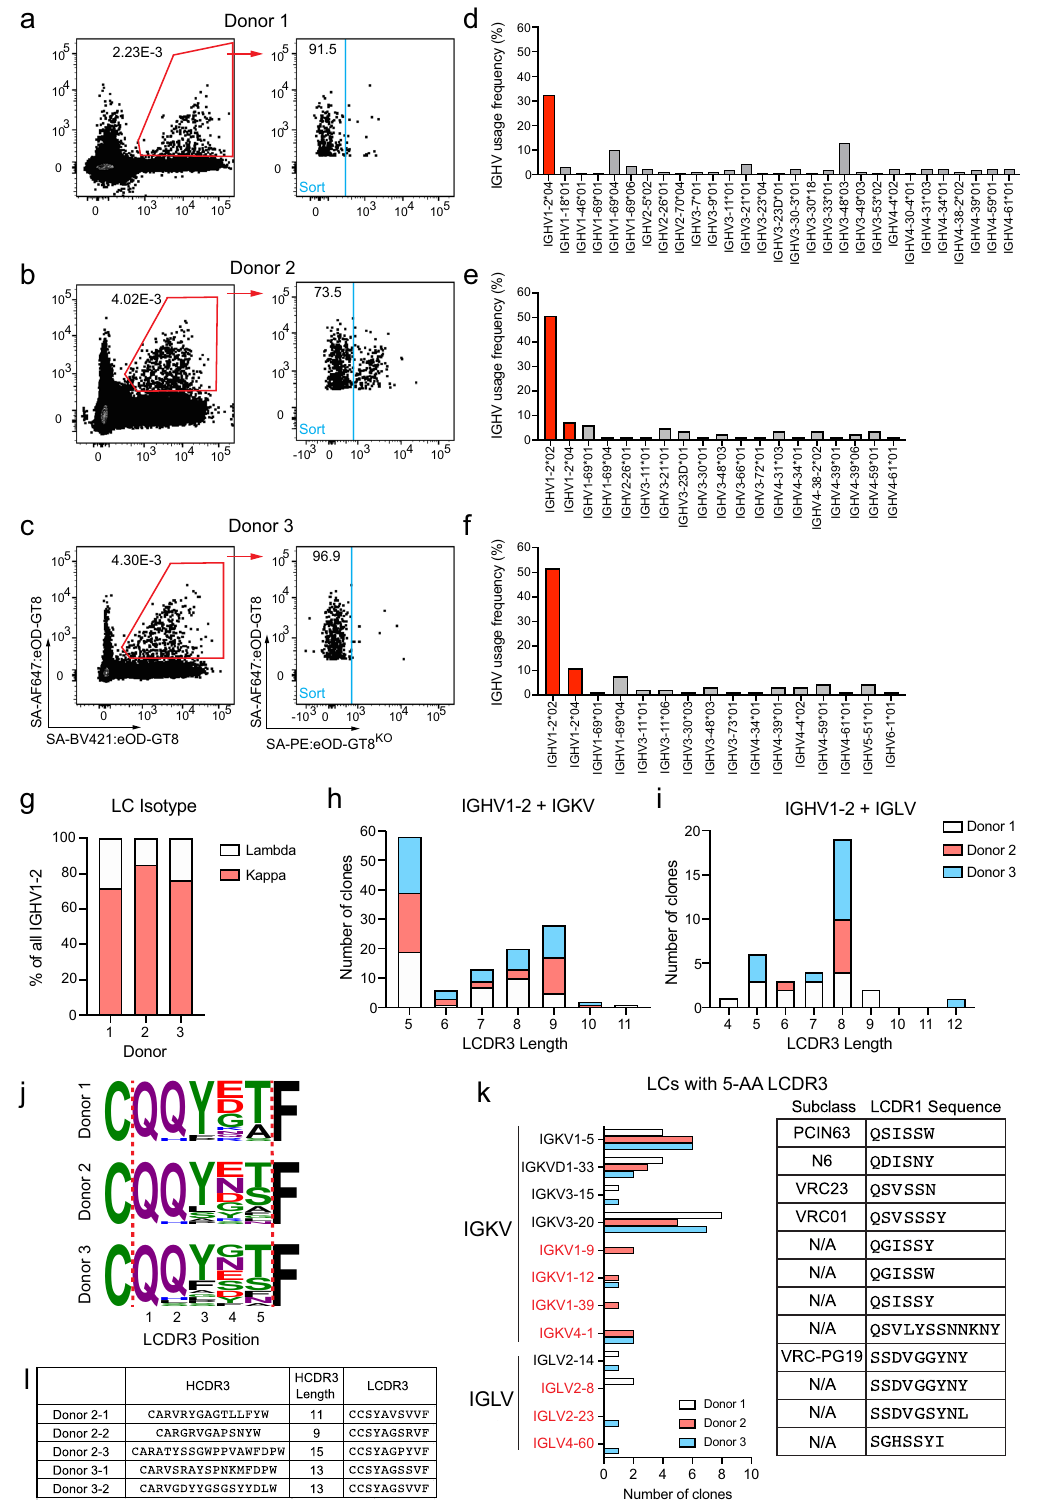
Fig. 1 eOD-GT8 tetramer sorted VRC01-class naive B cells. B cells enriched from healthy donor PBMCs were stained with SA: eOD-GT8 tetramers, and sorted for IgG neg /eOD-GT8 ++ eOD-GT8 KOneg B cells, followed by BCR sequencing. a – c Flow cytometry of sorted cells in donor 1 ( a ), donor 2 ( b ), and donor 3 ( c ). Sorted cells are from the gate shown in blue. d – f IGHV gene usage distribution of paired IgG neg /eOD-GT8 ++ eOD- GT8 KOneg B cells from donor 1 ( d ), donor 2 ( e ), and donor 3 ( f ). Bars corresponding to IGHV1-2 genes are colored in red. g Isotype distribution of LCs coexpressed with IGHV1-2. h LCDR3 lengths of IGKV LCs coexpressed with IGHV1-2. i As in h , but for IGLV LCs. j LCDR3 sequences of naive 5-AA IGKV LCs. k IGKV and IGLV usage distribution among eOD-GT8 ++ eOD-GT8 KOneg 5-AA LCDR3 VRC01-class naive B cells and their germline encoded LCDR1 sequences (right). IGKV and IGLV genes shown in black are genes observed in known VRC01-class bnAbs, whereas those indicated in red have not been observed. l IOMA-class B cells identi fi ed using tetramer